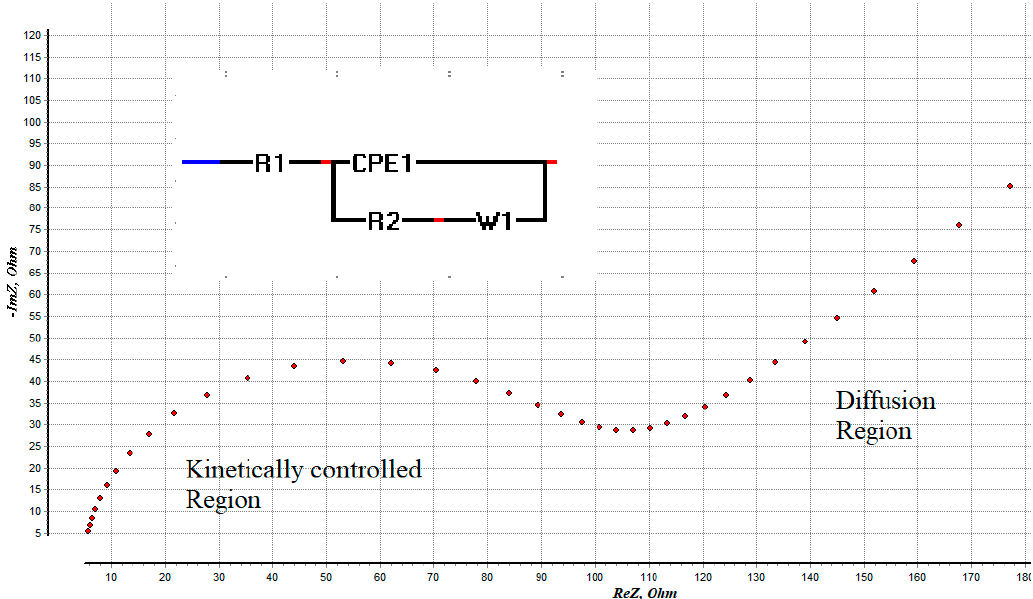
Figure 9. Representation of a Nyquist plot with its equivalent circuit and its related components.